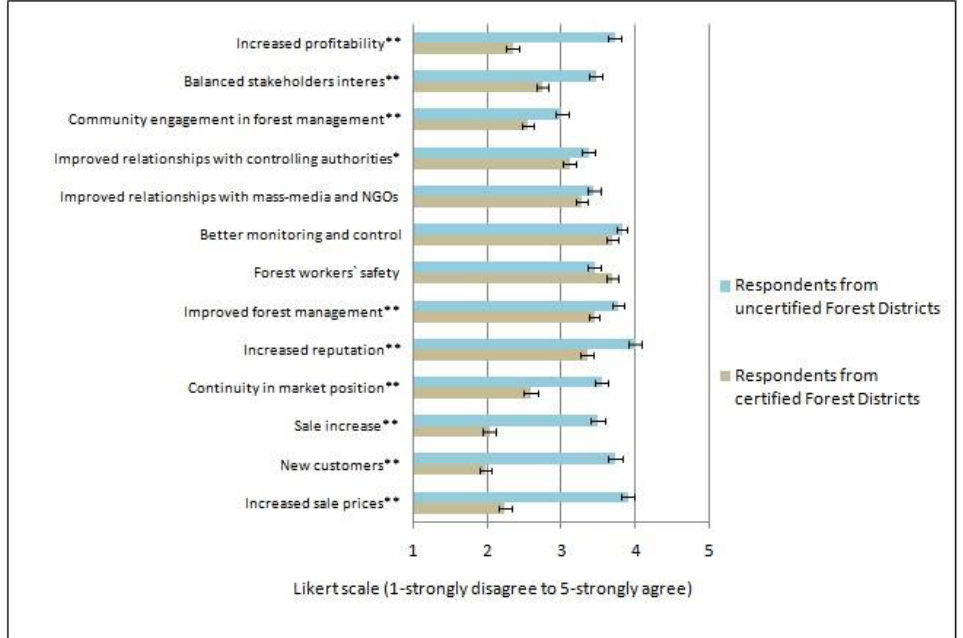
Figure 10. Perception of FDs managers and FDs FSC responsible persons regarding the expected/obtained benefits of FSC certification (Mann Whitney U test: * p < 0.05; ** p < 0.01) (Likert scale question: Indicate, on a scale from 1 to 5, the importance of the analyzed benefits associated with FSC certification) (in Supplementary).